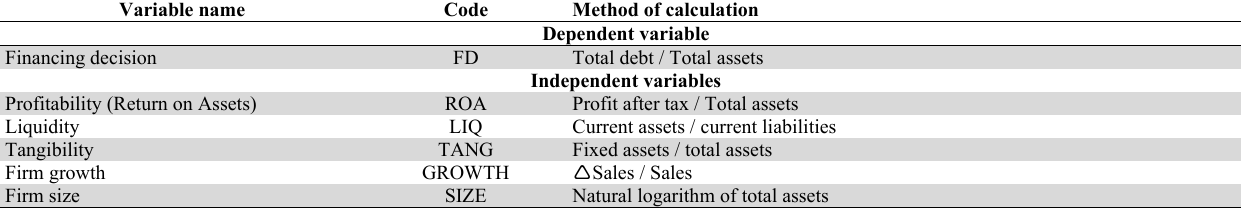
Summary of variables in the study model